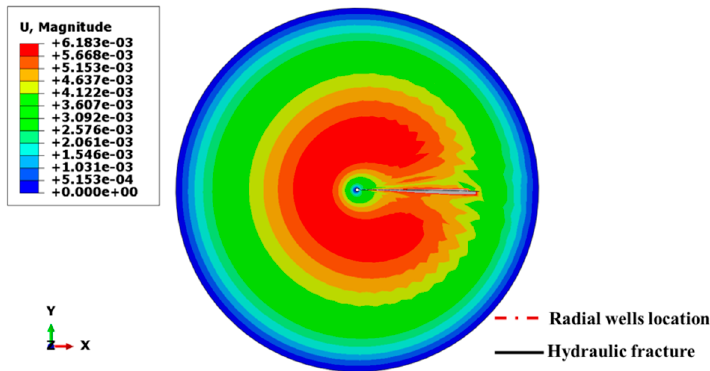
Figure 4. Simulation result of hydraulic fracture propagation without the guidance of radial well.